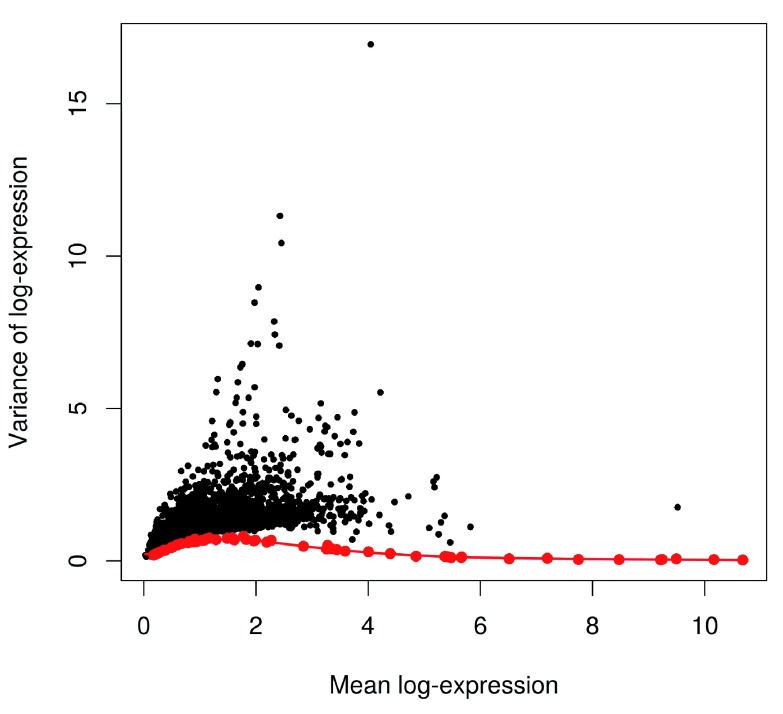
Variance of normalized log-expression values for each gene in the brain dataset, plotted against the mean log-expression.The red line represents the mean-dependent trend in the technical variance of the spike-in transcripts (also highlighted as red points).